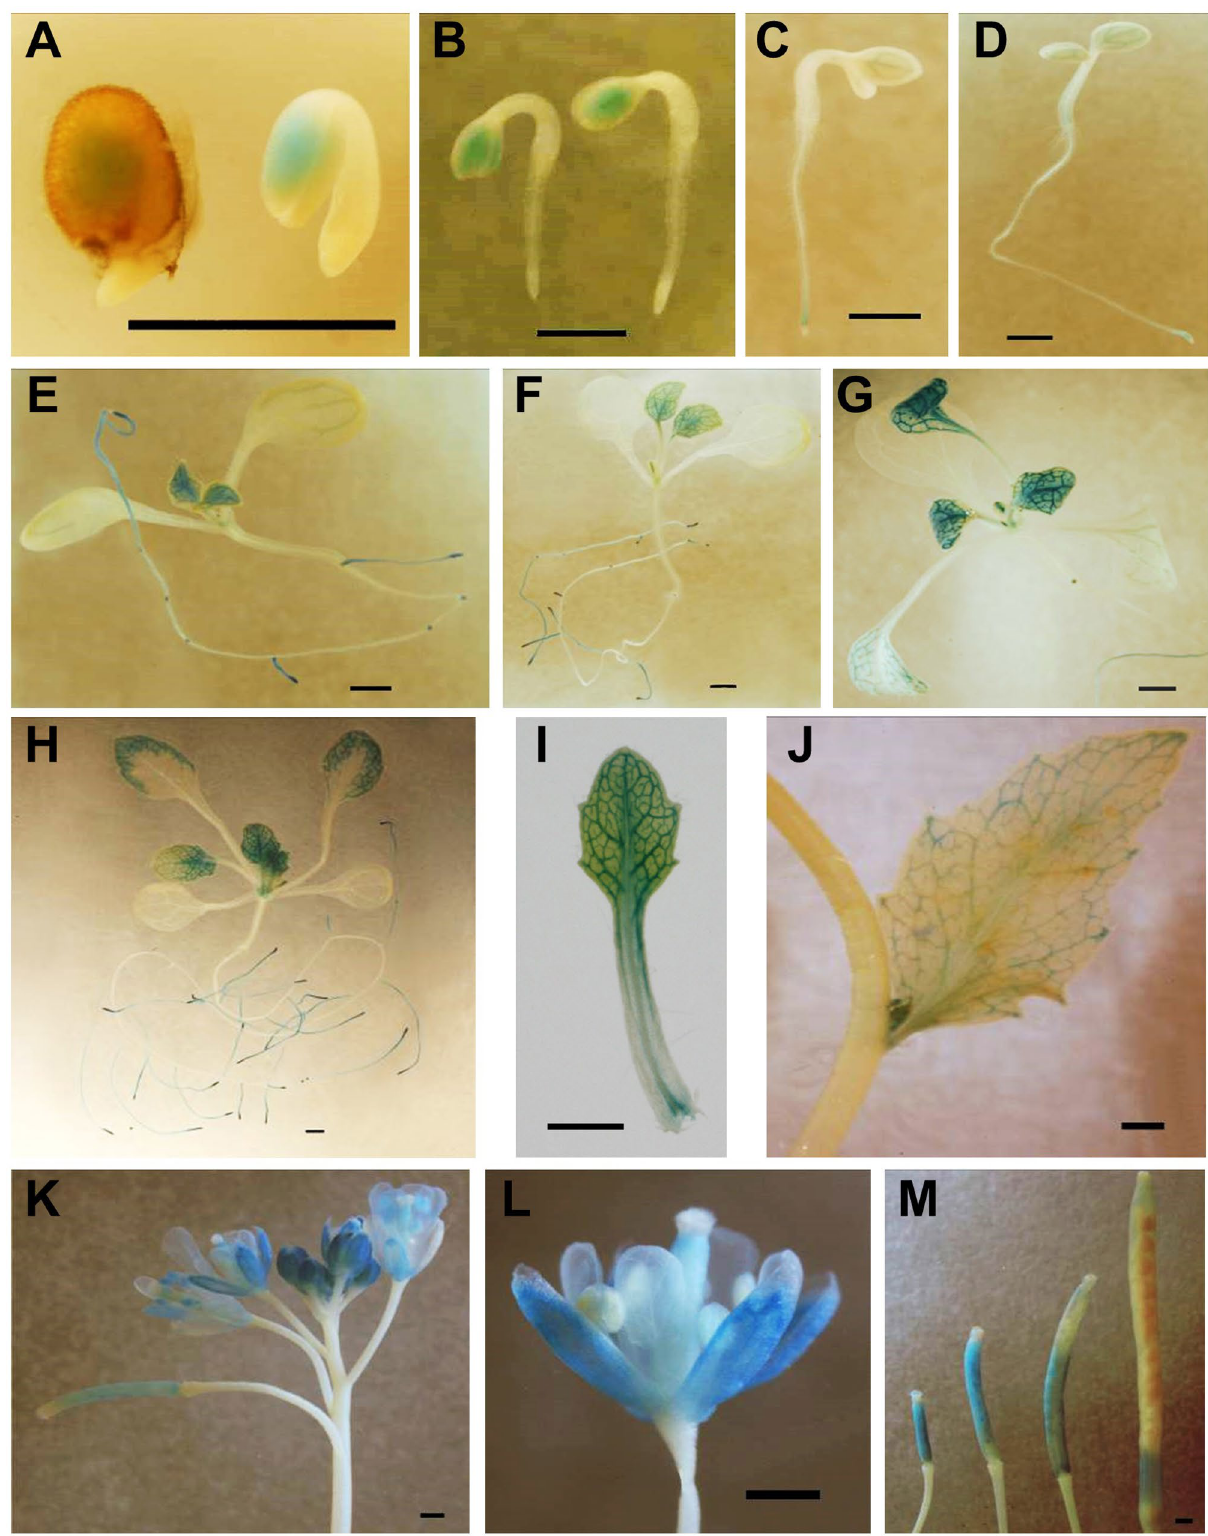
Figure 3. The expression pattern of UGT74D1 gene reported by GUS expression. ( A – D ) UGT74D1 expression was found mainly in the cotyledon for 1 to 4-day old seedlings. ( E – G ) UGT74D1 expression was found mainly in whole young leaf and root tip. ( H ) UGT74D1 expression was moved to leaf edge in mature leaf. ( I ) UGT74D1 was expressed in young leaf petioles. ( J – M ) UGT74D1 expression was found in veins of cauline leaf, flower and young silique. Scale bar = 1